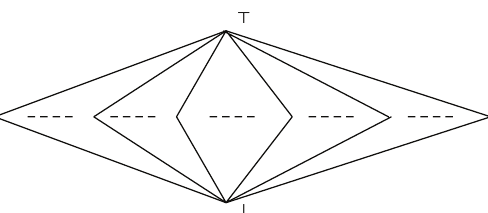
Figure 1: A complete lattice with countably directed sets having maximal